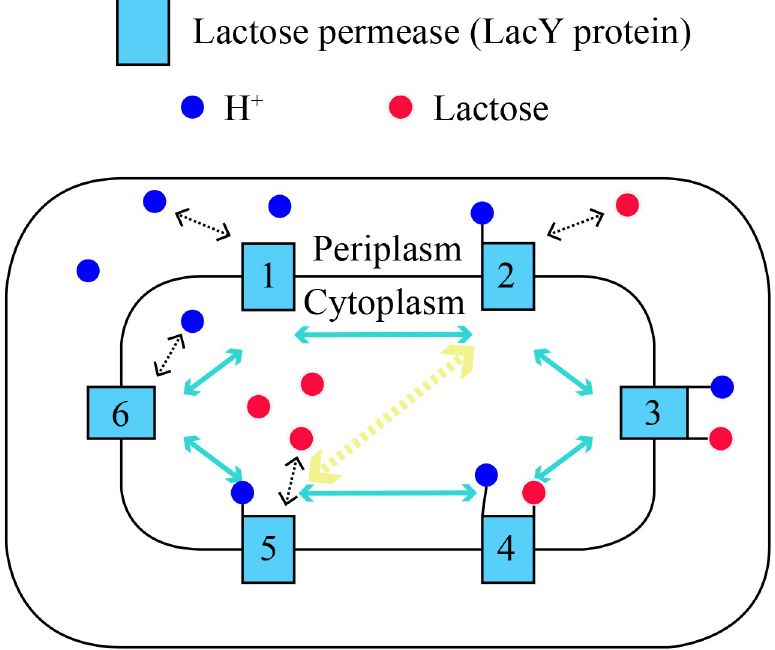
Fig 1. The modified six-state mechanism of cotransport. An alternating access model of E . coli lactose—H + cotransport by Jardetzky modified with the transition between cotransporter states 2 and 5. A simple schematic of the “six-state” mechanism of cotransporter LacY protein of E . coli during cotransport is shown in the figure above. Numbers 1 to 6 indicate state 1 to state 6, which are the six effective conformations of LacY protein. The blue double- head arrows refer to the six states of cotransporter in relation to each other, and the yellow dashed arrow refers to the way to modify the present model—allowing the transition between cotransporter states 2 and 5.